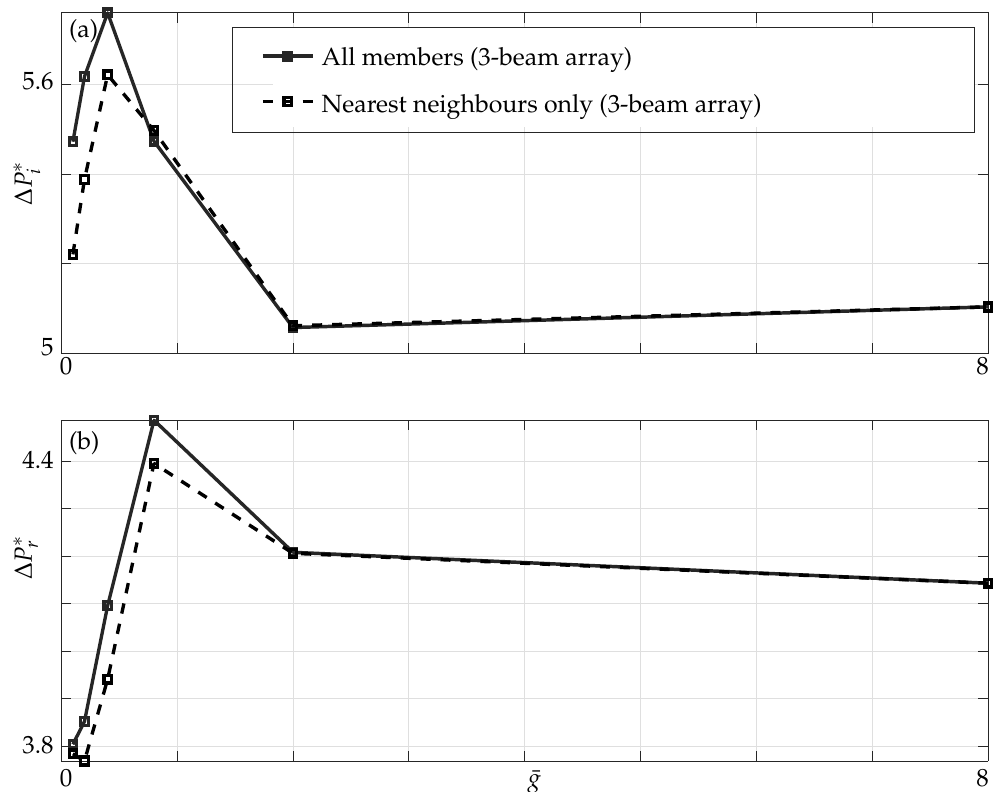
Figure 9. ( a ) Imaginary and ( b ) real parts of nondimensional pressure evaluated at the mid point of the active beam in a three-beam array (1–0–0 configuration) for different nondimensional gaps; nearest neighbours only (dashed lines) and all members incorporated (solid lines) at Re = 1.